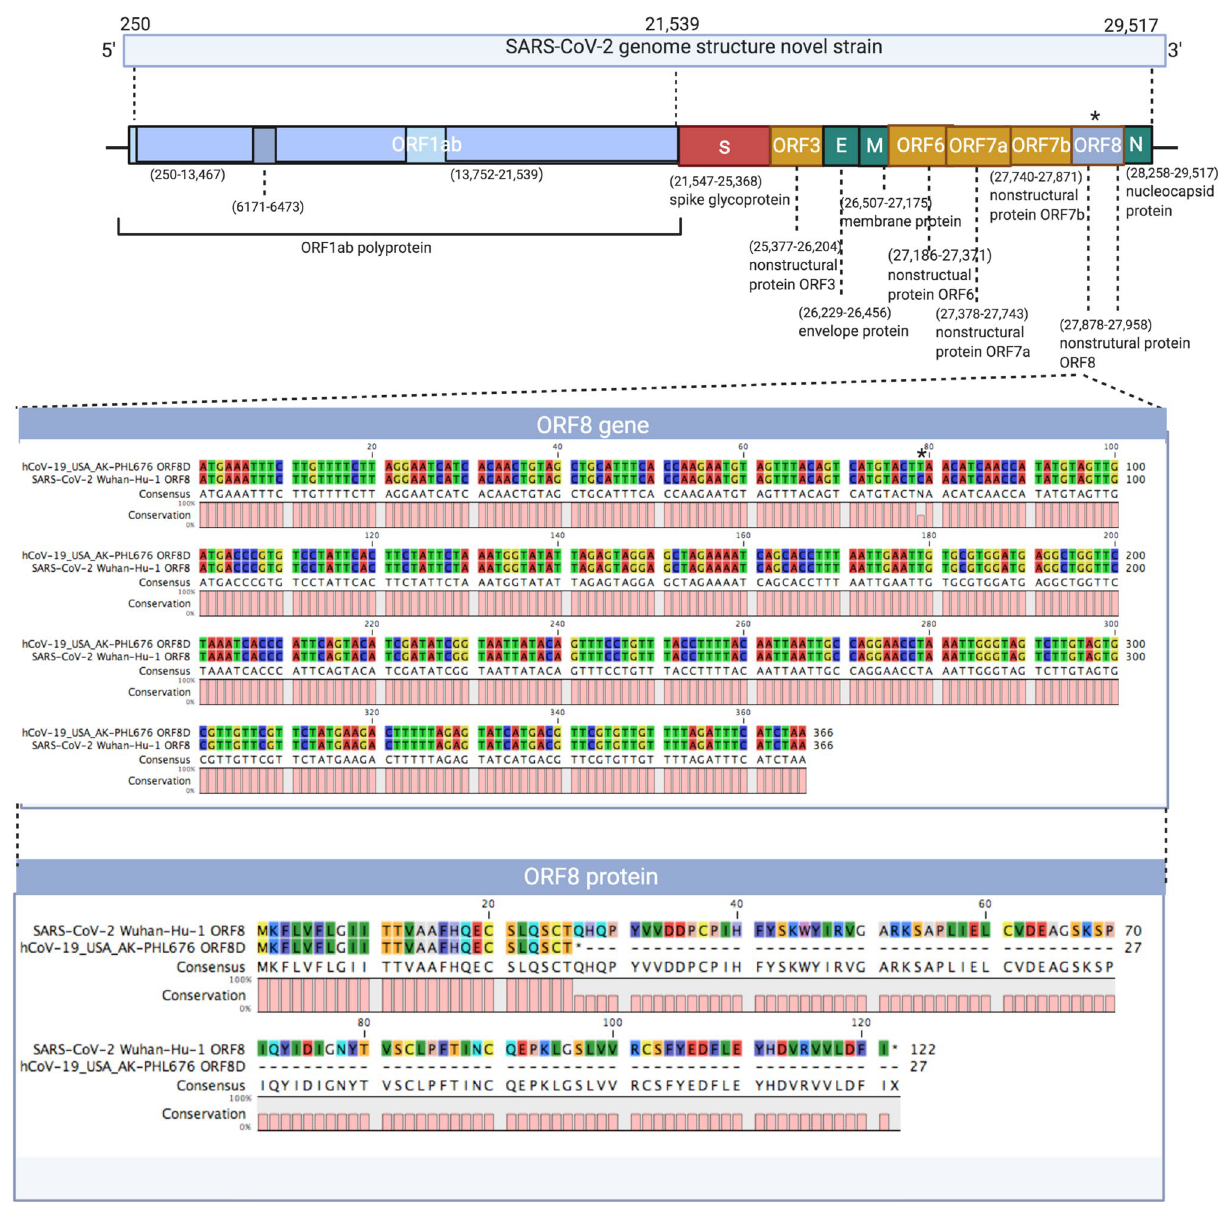
Figure 1. Genomic structure of novel SARS-CoV-2 variant. ORF8 gene sequences is enlarged and shown along with ORF8 amino acid sequences for both SARS-CoV-2 Wuhan-Hu-1 reference sequence and hCoV- 19/USA/AK-PHL676/2020 truncated mutation variant. The reference sequence SARS-CoV-2 Wuhan-Hu-1 shows the wild type gene length which translates to the ORF8 protein. * indicates where the point mutation occurred creating the truncation in the ORF8 protein. This figure was created using CLC Sequencing Viewer, a part of CLC Genomics Workbench, for alignment of multiple sequences. Consensus sequence is determined by the software, it gives an identical nucleotide when all sequences at that position are the same, and a different nucleotide (in this case, a N) to represent the difference in each sequence. Conservation is also determined by the software, and is presented as 0–100% conservation value in a specific